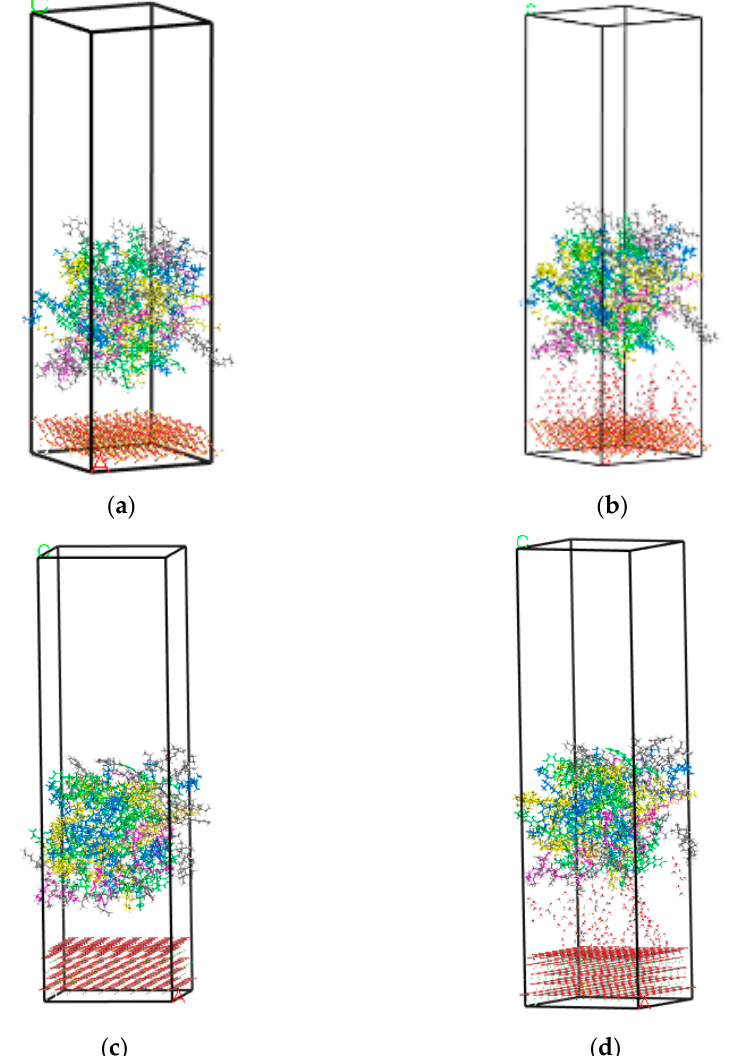
Table 10. Loading conditions of SCB.